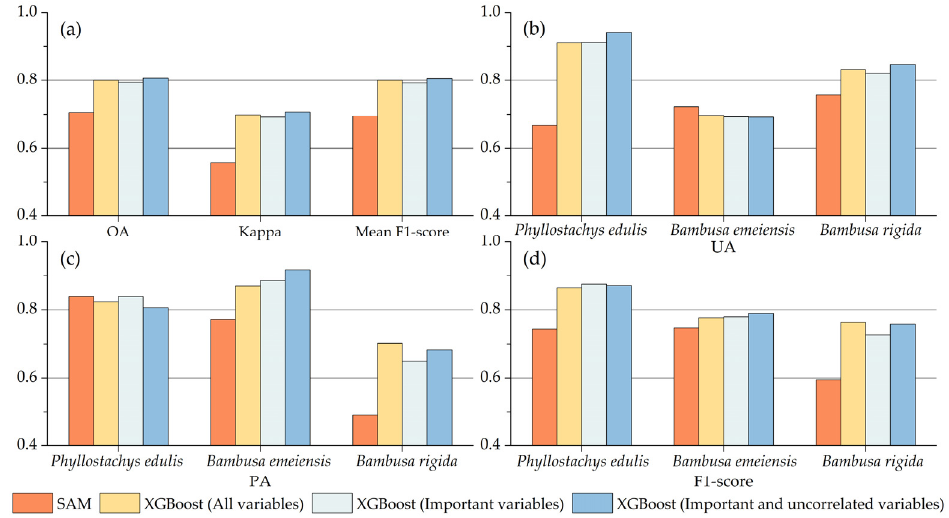
Figure 11. Comparison of evaluation indicators between SAM and three XGBoost classification results: ( a ) OA, kappa, and mean F1-score; ( b ) UA; ( c ) PA; and ( d ) F1-score of bamboo species.